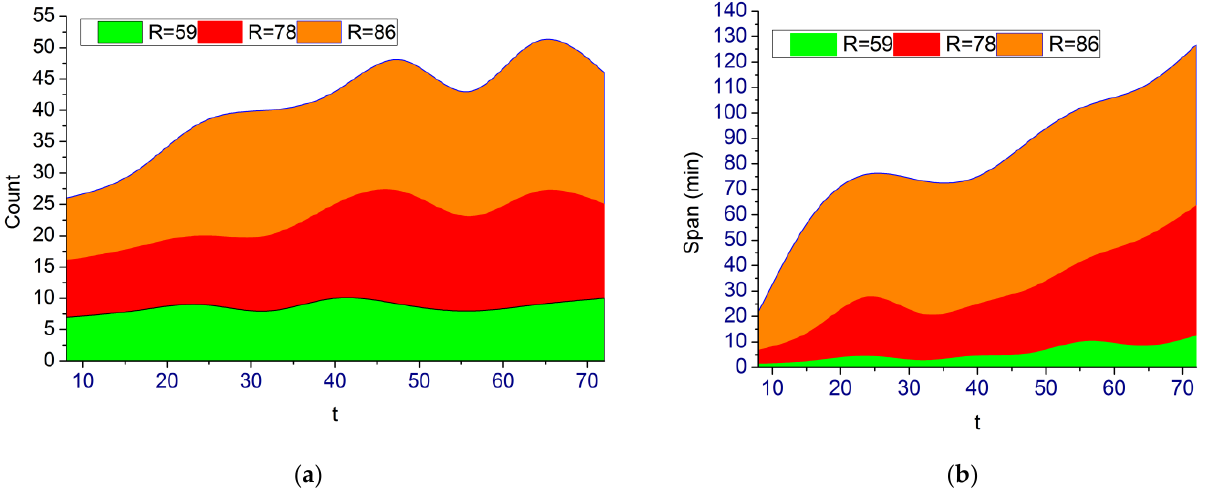
Figure 6. Count and Span Analysis. ( a ) Count. ( b ) Span Analysis.